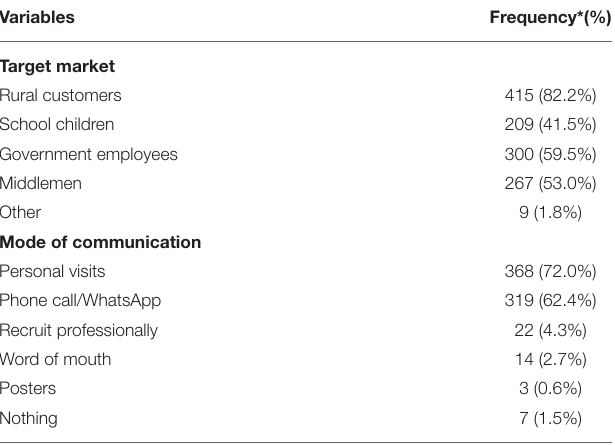
TABLE 8 | Total running cost and